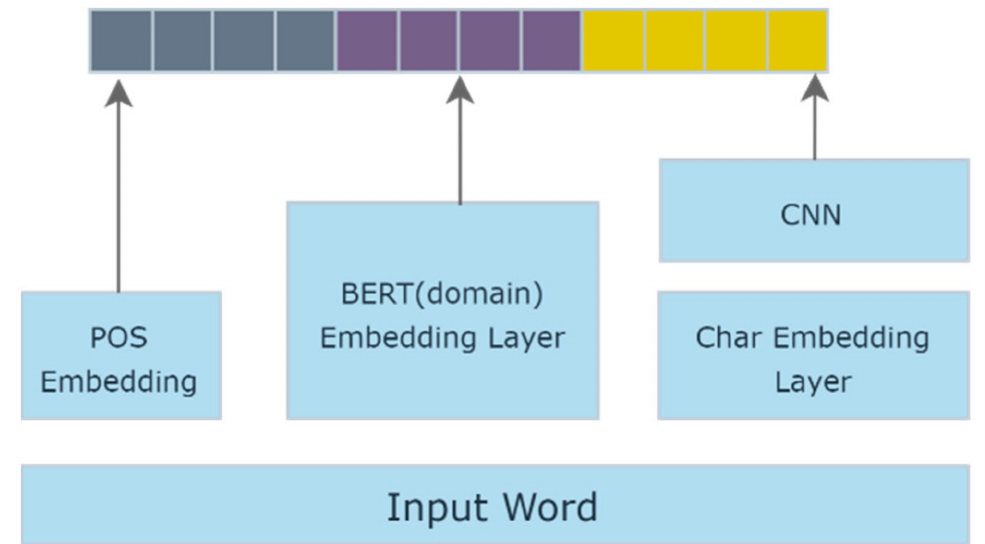
Figure 3. Embedding vector from different level of